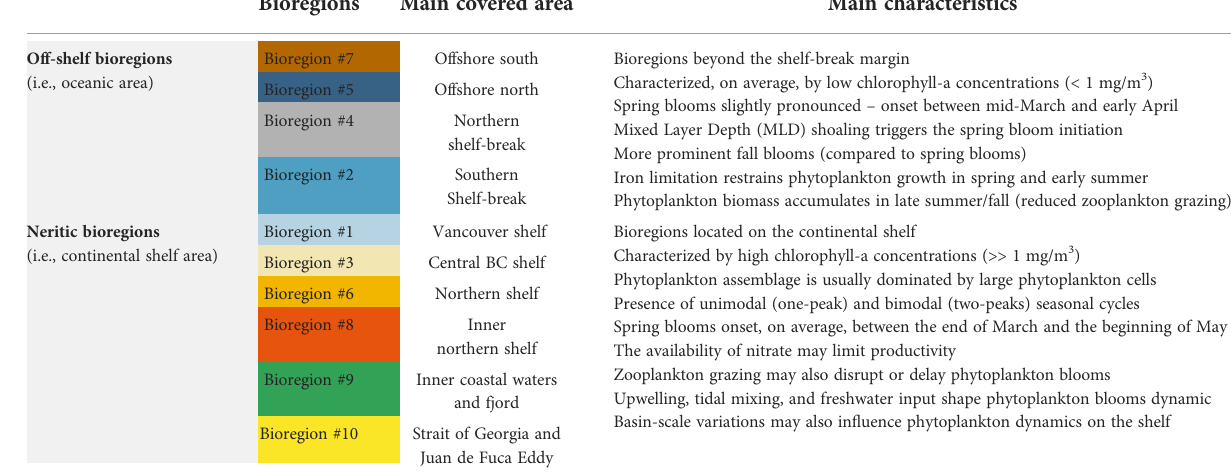
TABLE 1 Main characteristics of neritic and off-shelf